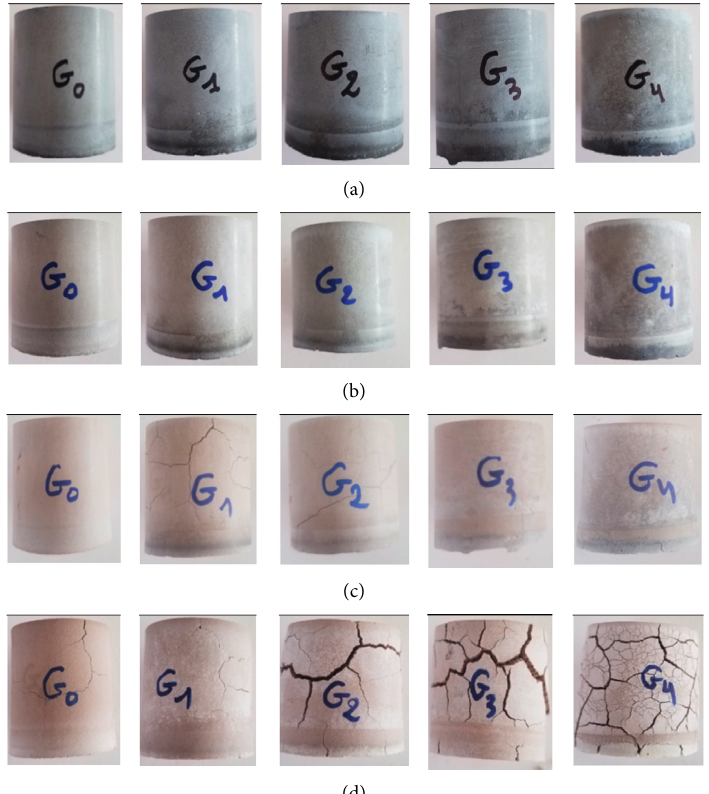
Figure 8: The photographs of geopolymers specimens cared for at different temperatures. (a) 200 ° C. (b) 400 ° C. (c) 600 ° C. (d) 800 °